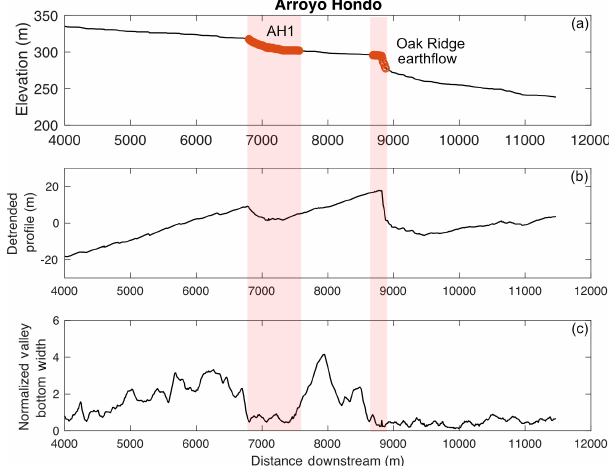
Figure 5. (a) Elevation long profile of Arroyo Hondo. Locations where the channel intersects mapped earthflows in Figs. 2 and 3 are shown in red and labeled. (b) Detrended elevation profile of Arroyo Hondo for the reach shown in panel (a) . (c) Valley bottom width for Arroyo Hondo normalized by the mean valley bottom width over the reach shown in panel (a) . In panels (a) – (c) , the red boxes highlight earthflow-impacted reaches.